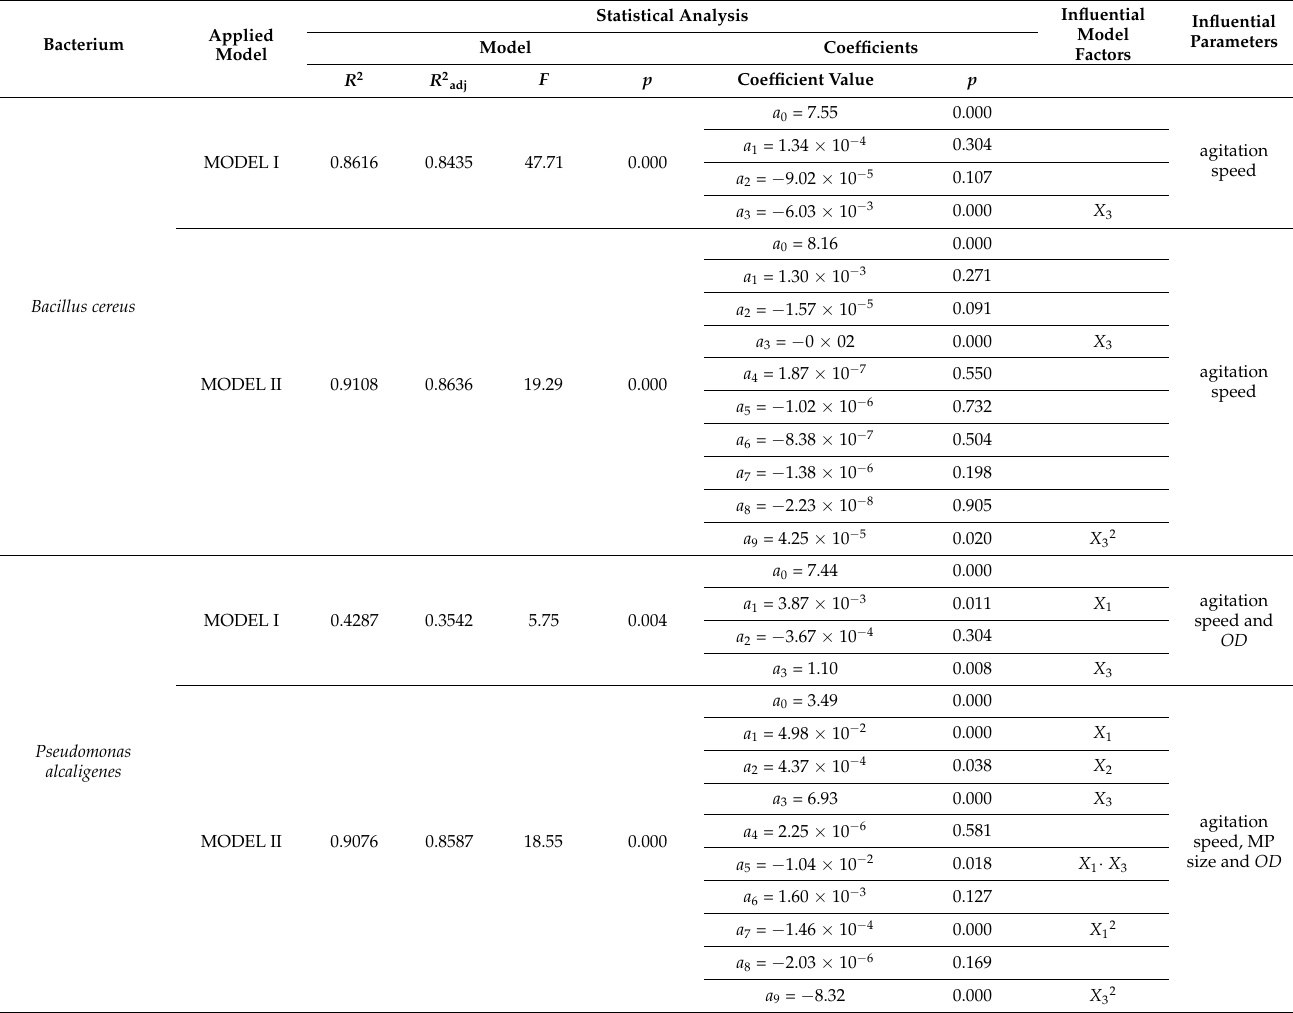
Table 5. ANOVA analysis for obtained models for MP-PS biodegradation by Bacillus cereus and Pseudomonas alcaligenes